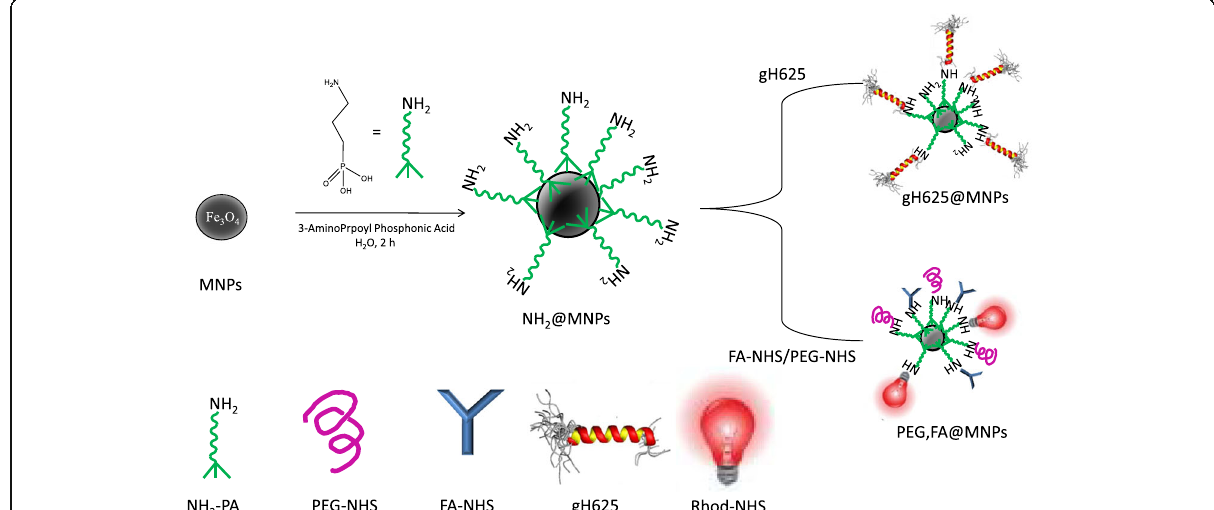
Fig. 1 Reaction scheme. Reaction steps for the preparation of functionalized